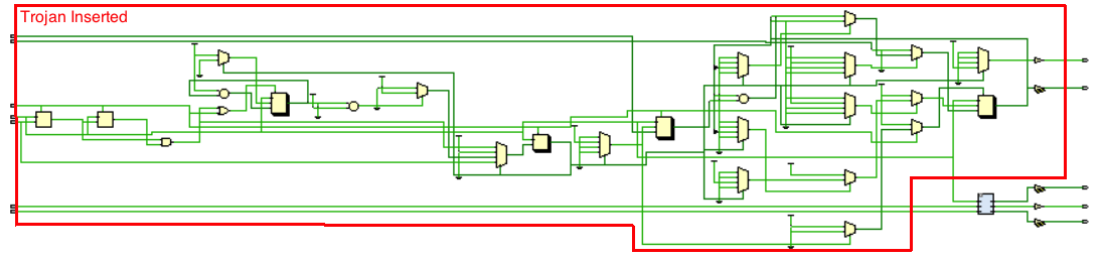
Figure 3. Trojan-inserted Elaborated Design